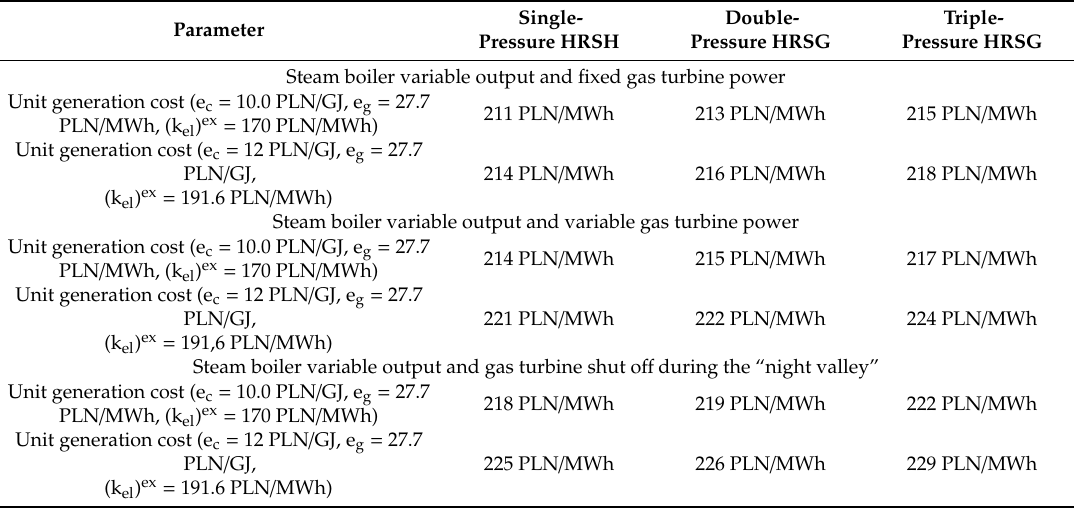
Table 2. Comparison of the most important economic parameters for various structure of HRSG. Parameter